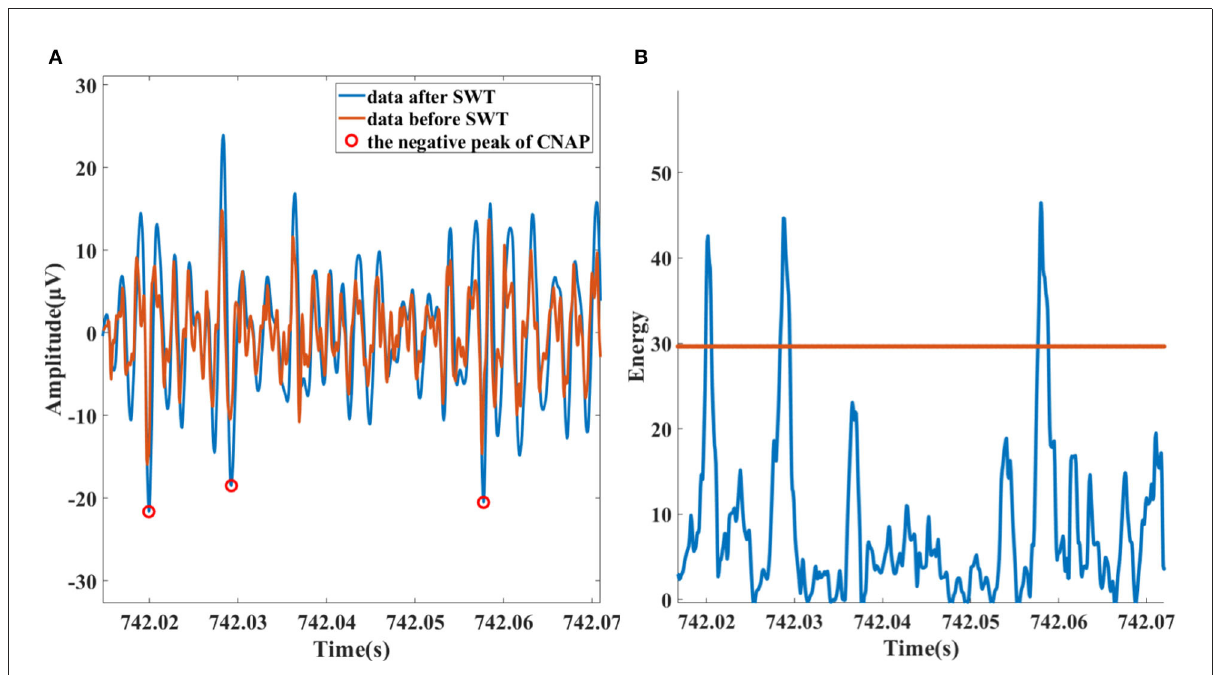
FIGURE3 (A) Data and the peak of detected neural spike before (red) and after (blue) SWT enhancing. (B) Spike detection based on Teager energy